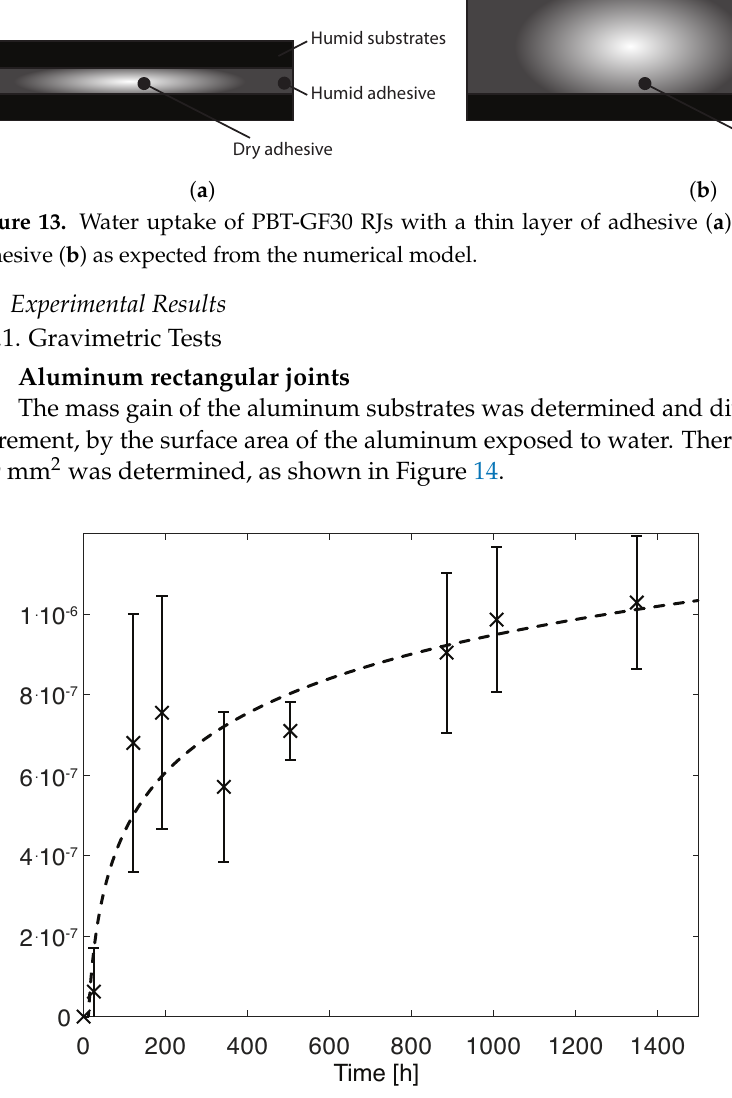
Figure 14. Mass gain of aluminum substrates immersed in